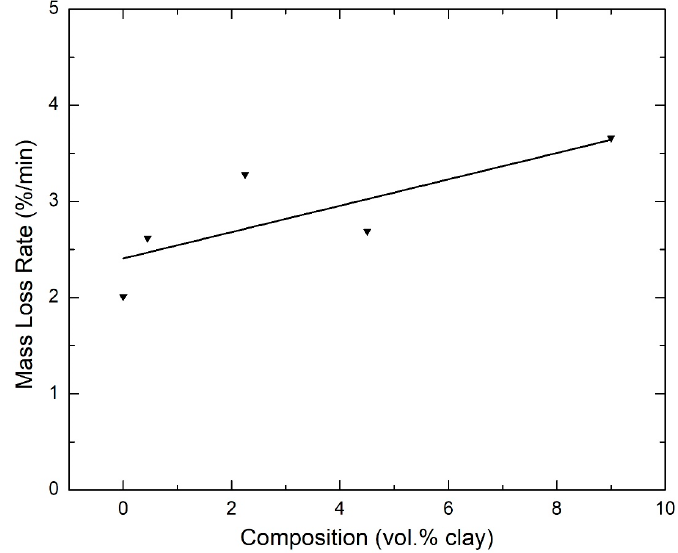
Figure 5. Variation of the rate of degradation of the polymer matrix as a function of the volume percentage of clay in the nanocomposites (in nitrogen; β = 30 °C/min).